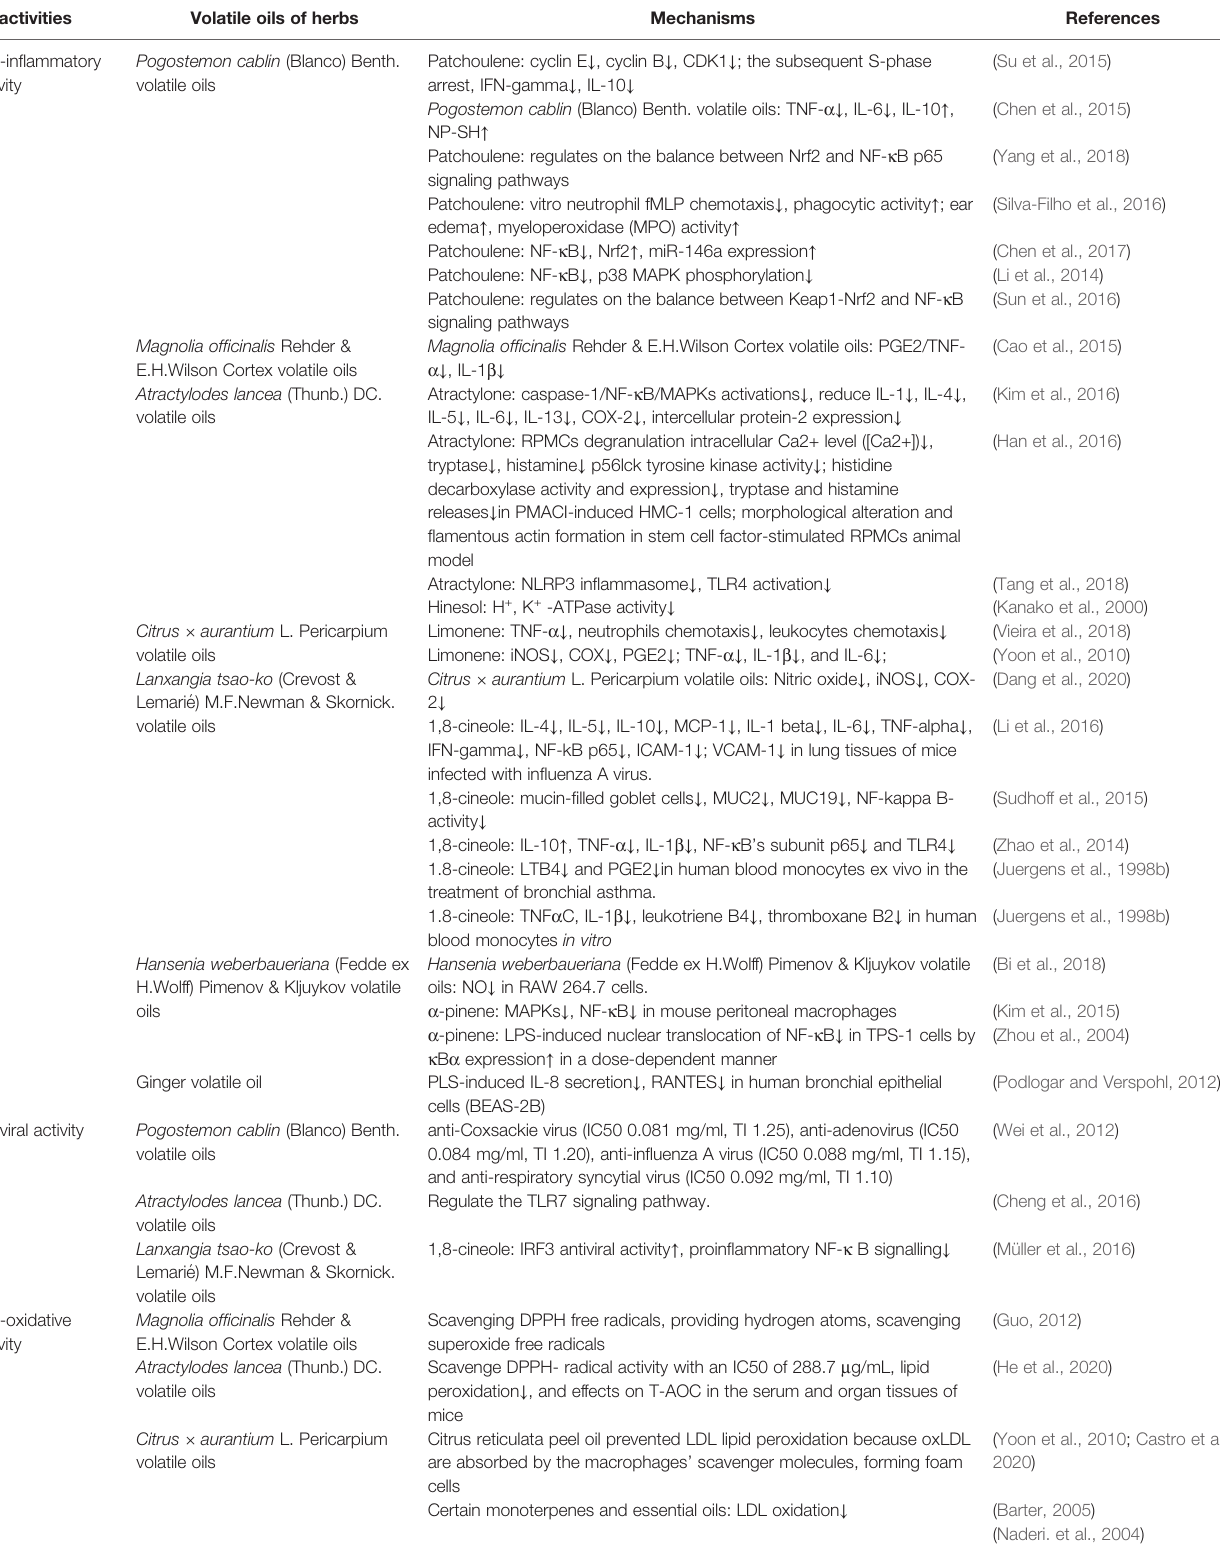
TABLE 2 | The mechanism of action of volatile components in Dayuanyin